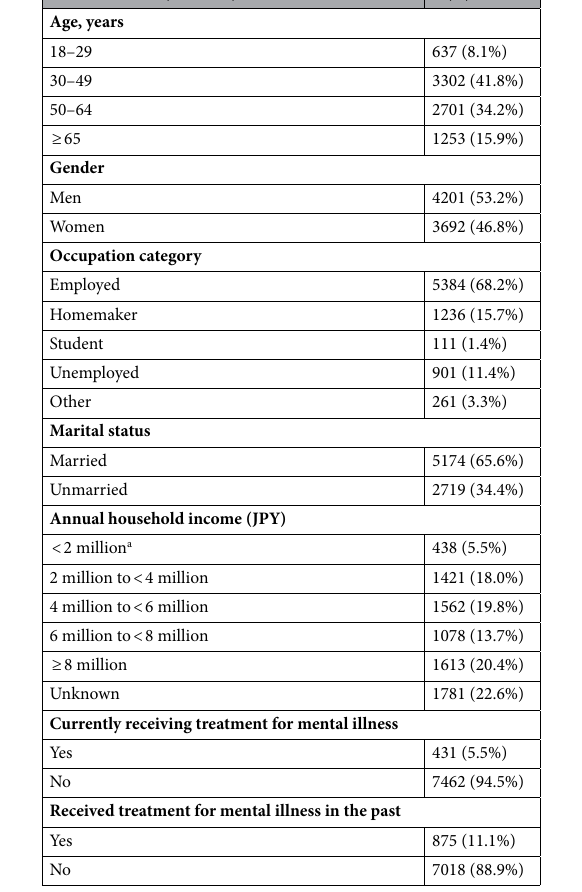
Table 1. Demographic characteristics of the participants. a 2 million JPY = approximately £15,000.